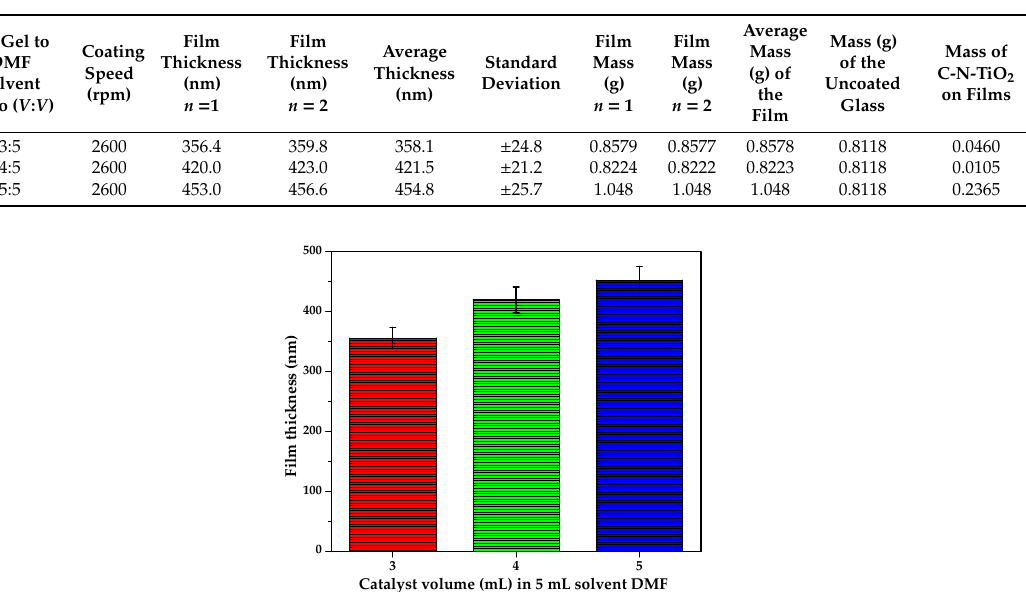
Figure 6. Effect of sol gel to solvent volume ratio on the thickness of films at the following conditions: coating speed 2600 rpm, spinning time 90 s, pyrolysis temperature 350 °C (ramping rate of 10 °C/min) for 105 min. The sol gel to solvent volume ratio ( V : V ) was varied from 3:5, 4:5, to 5:5. The thickness of each sample was measured twice ( n =2).